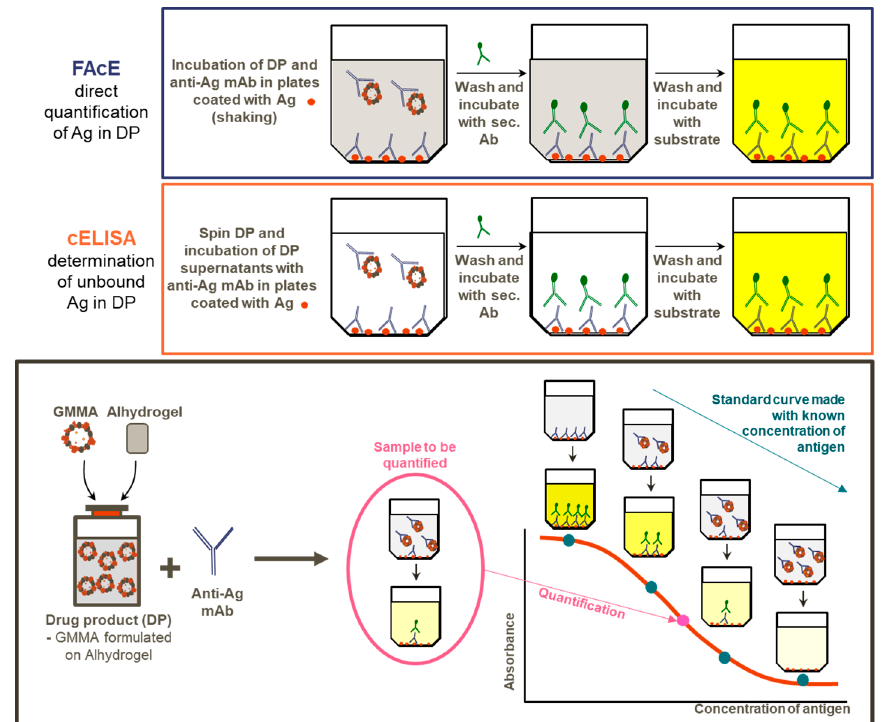
Figure 1. Visual descriptions of methods. Generalized modules for membrane antigens (GMMA) are formulated in Alhydrogel and their OAg content (active ingredient) can be directly quantified by Formulated Alhydrogel competitive ELISA (FAcE), whereas the quantity of unbound material can be determined by competititve ELISA (cELISA) performed on drug product supernatant. Both assays are quantitative and rely on standard curves made with a known quantity of antigen assayed in parallel to samples with unknown quantity. Samples and standard curve points compete with coated antigen for a limited amount of anti-antigen (anti-Ag) specific monoclonal antibodies (mAb) in a similar